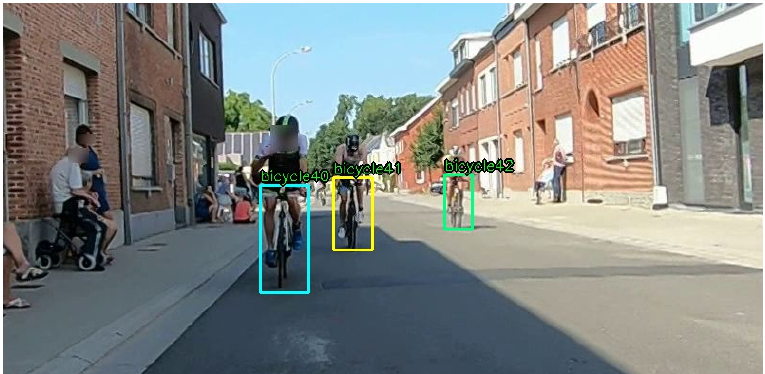
Figure 2. Example of a frame with manually annotated bounding boxes from our training set, captured at a non-drafting triathlon race in Kapelle-op-den-Bos,